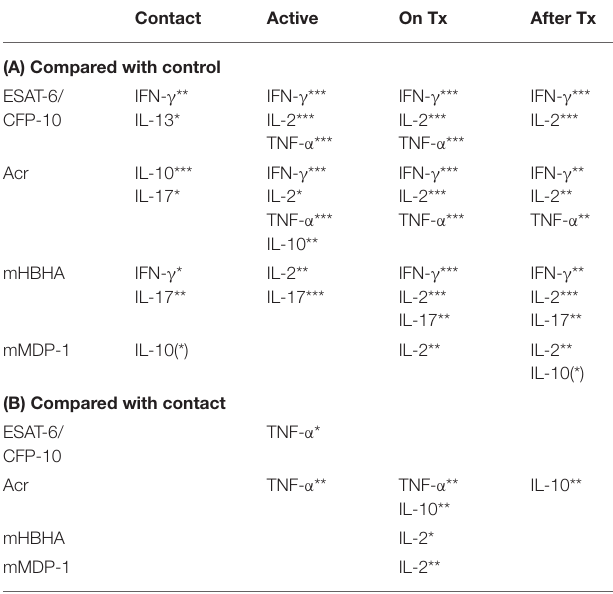
TABLE 2 | Summary of cytokine responses.